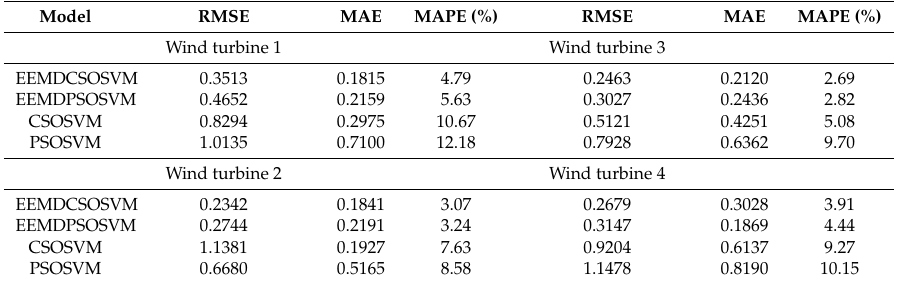
Table 2. Comparison of the value of RMSE, MAE, and MAPE between the proposed model and some related models.